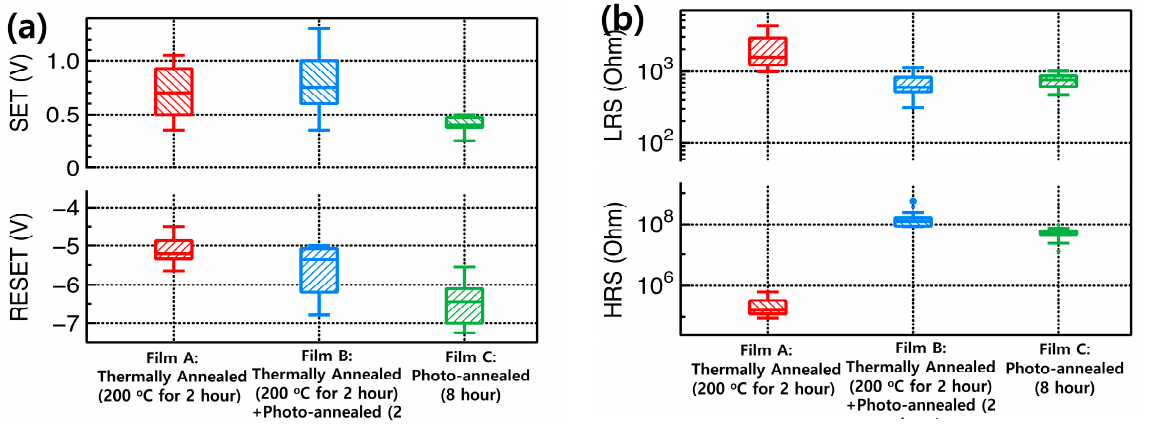
Figure 7. Extracted performance parameters of the ITO/Y 2 O 3 /Ag RRAM devices: ( a ) SET and RESET voltages; ( b ) LRS and HRS values.